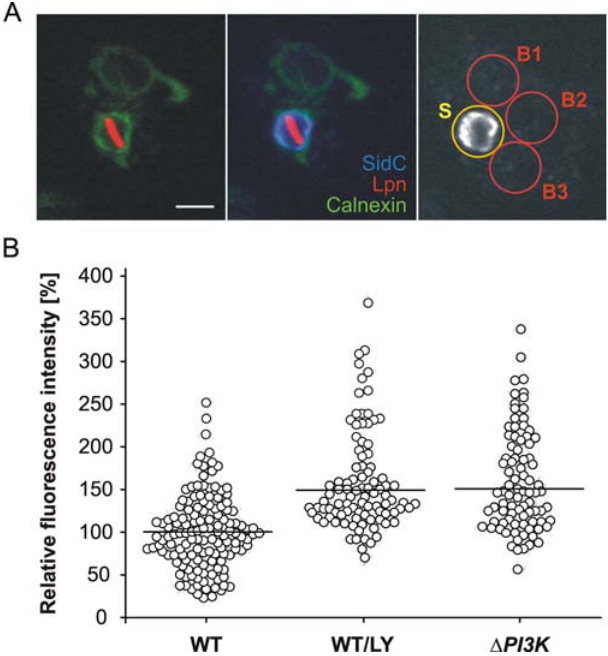
Figure 6. PI3Ks Affect the Amount of SidC Bound to LCVs in Dictyostelium (A) Confocal laser scanning micrographs of calnexin-GFP–labeled Dictyostelium wild-type strain Ax3 (green), infected with DsRed- Express–labeled wild-type L. pneumophila (red) for 1 h (left panel), and immuno-labeled for SidC (blue) with an affinity-purified primary and Cy5- conjugated secondary antibody (middle panel). To quantify fluorescence intensity (right panel), the averaged fluorescence intensity of back- ground areas (B1, B2, and B3) was subtracted from the intensity of the sample area (S). Bar denotes 2 l m. (B) Dot plot of SidC fluorescence (average and variance) on LCVs within Dictyostelium wild-type (untreated, n ¼ 135; 20 l M LY, n ¼ 94) or D PI3K1/2 ( n ¼ 86). The data shown are combined from six independent experiments, each normalized to 100% (average SidC fluorescence on LCVs in wild-type Dictyostelium ). DOI: 10.1371/journal.ppat.0020046.g006